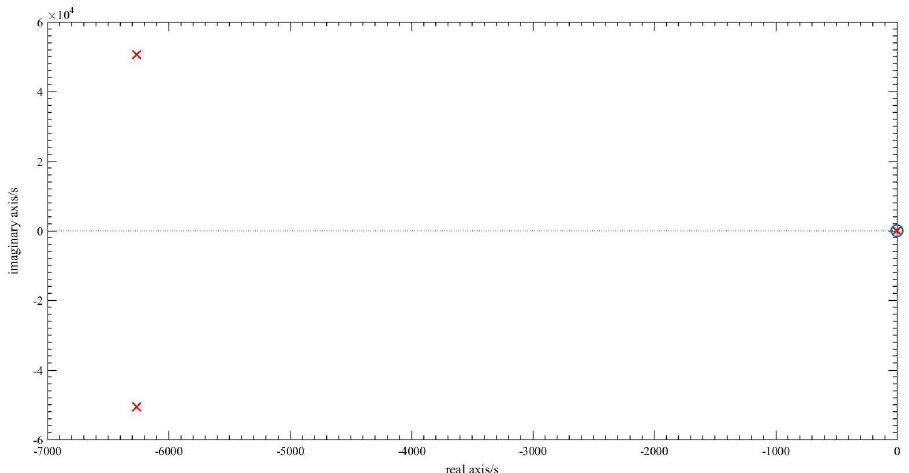
Figure 13. Root trajectory of double closed-loop control system.